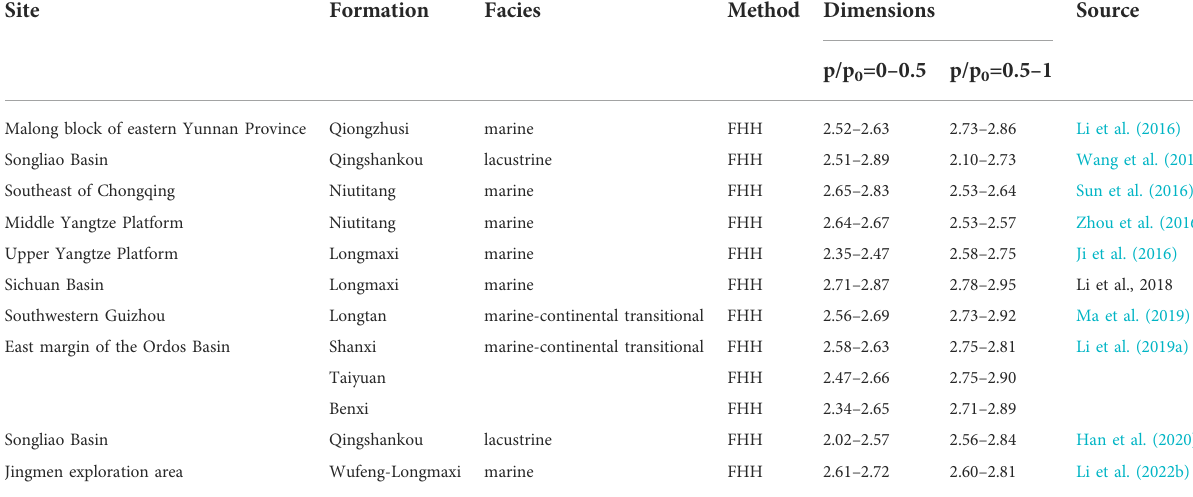
TABLE 3 Comparisons of the fractal dimensions of shale samples in different areas.